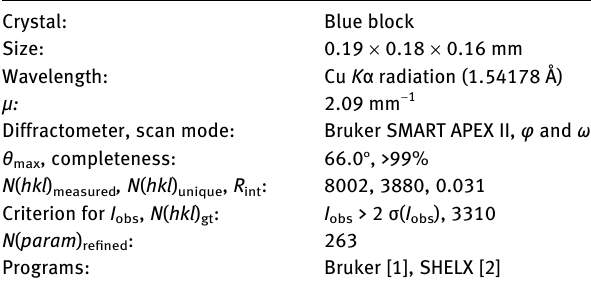
Table 2 contains the list of the atoms including atomic coordinates and displacement parameters.